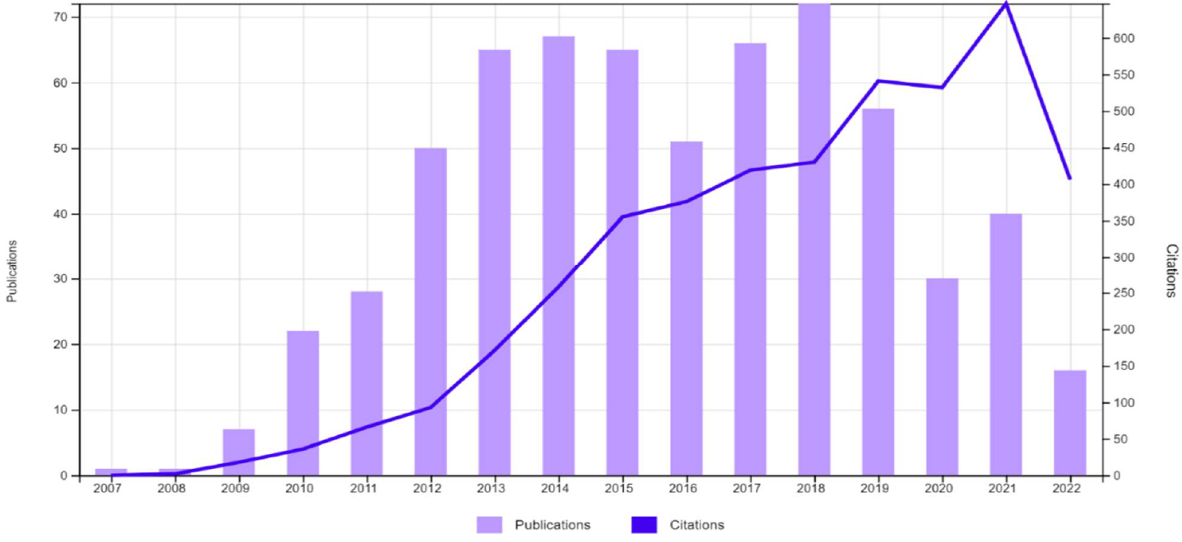
Figure 7. Citation analysis.